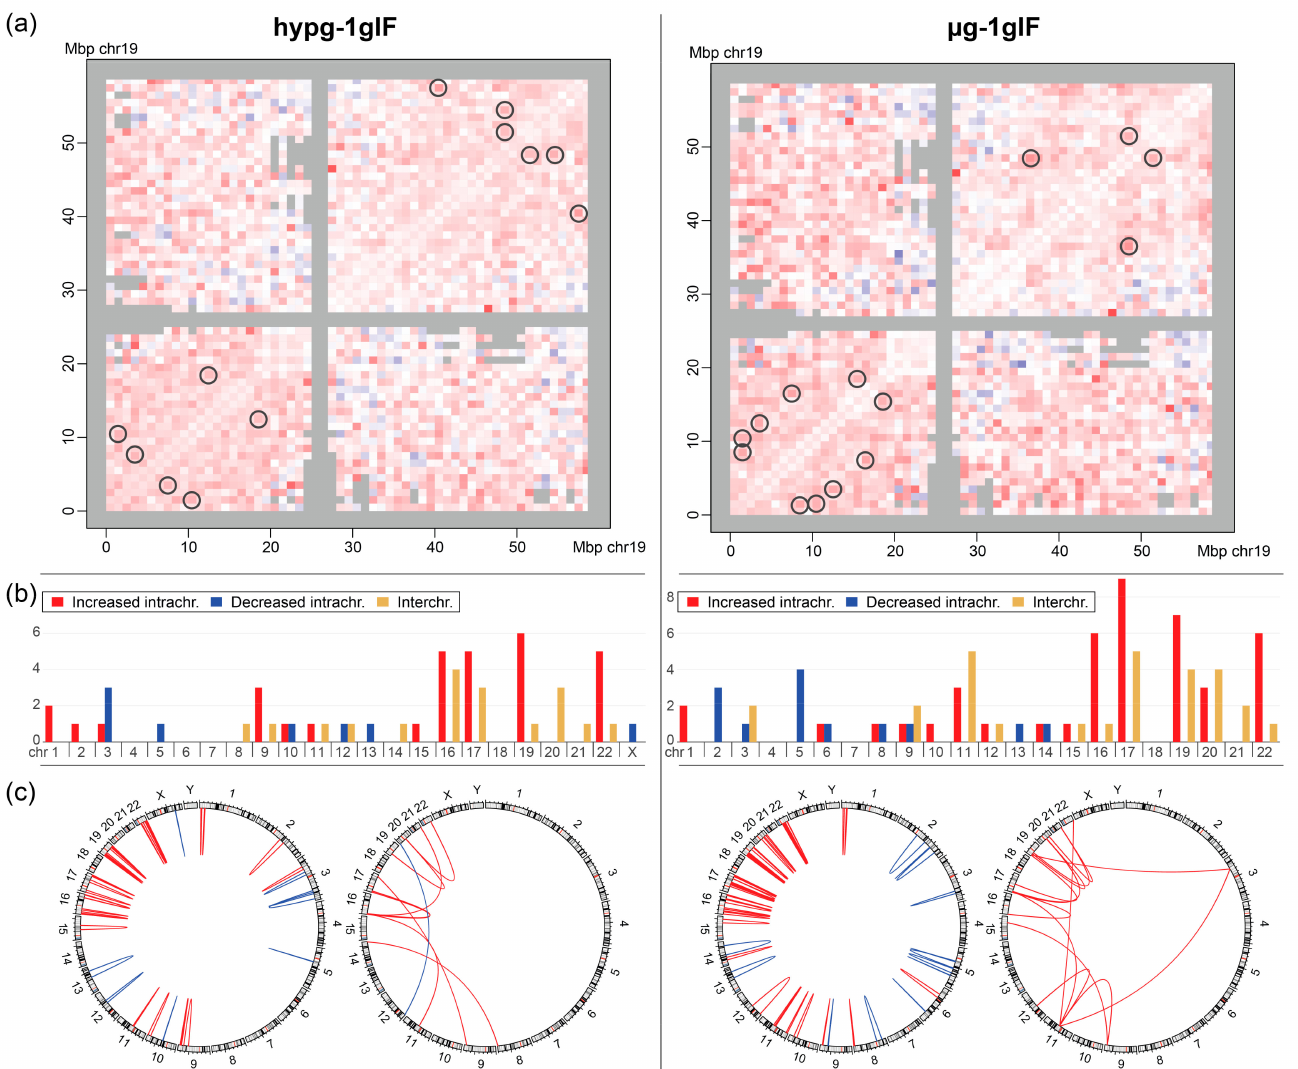
Figure 7. Differential chromosome conformation captured to analyze the effects of altered gravity. ( a ) For the comparisons between hypergravity and 1gIF and between microgravity and 1gIF samples, the Hi-C interaction maps were analyzed for significantly different interactions. Here, differential interaction is displayed for chromosome 19. Colors represent log fold changes, independently of signal strength. Bin pairs that show an increased interaction are highlighted in red, and decreased interaction is highlighted in blue. Bin pairs that show the most statistically significant interaction between conditions are circled. ( b ) Distribution of significantly different bin pairs over all chromosomes. Intrachromosomal bin pairs are stratified by increased and decreased interaction. For interchromosomal gene pairs, both contacts are listed separately; therefore, for one interaction, both chromosomes appear in the plot. Interchromosomal pairs are not split by increased and decreased interactions, since all of them are increased except for one interaction (compare c ). ( c ) Significantly different interactions for intra- (left circus plot) and interchromosomal (right circus plot) interactions. Increased and decreased interaction is color-coded. Intrachromosomal interactions that have bin pairs close to each other on the chromosome strand appear as strong single lines instead of